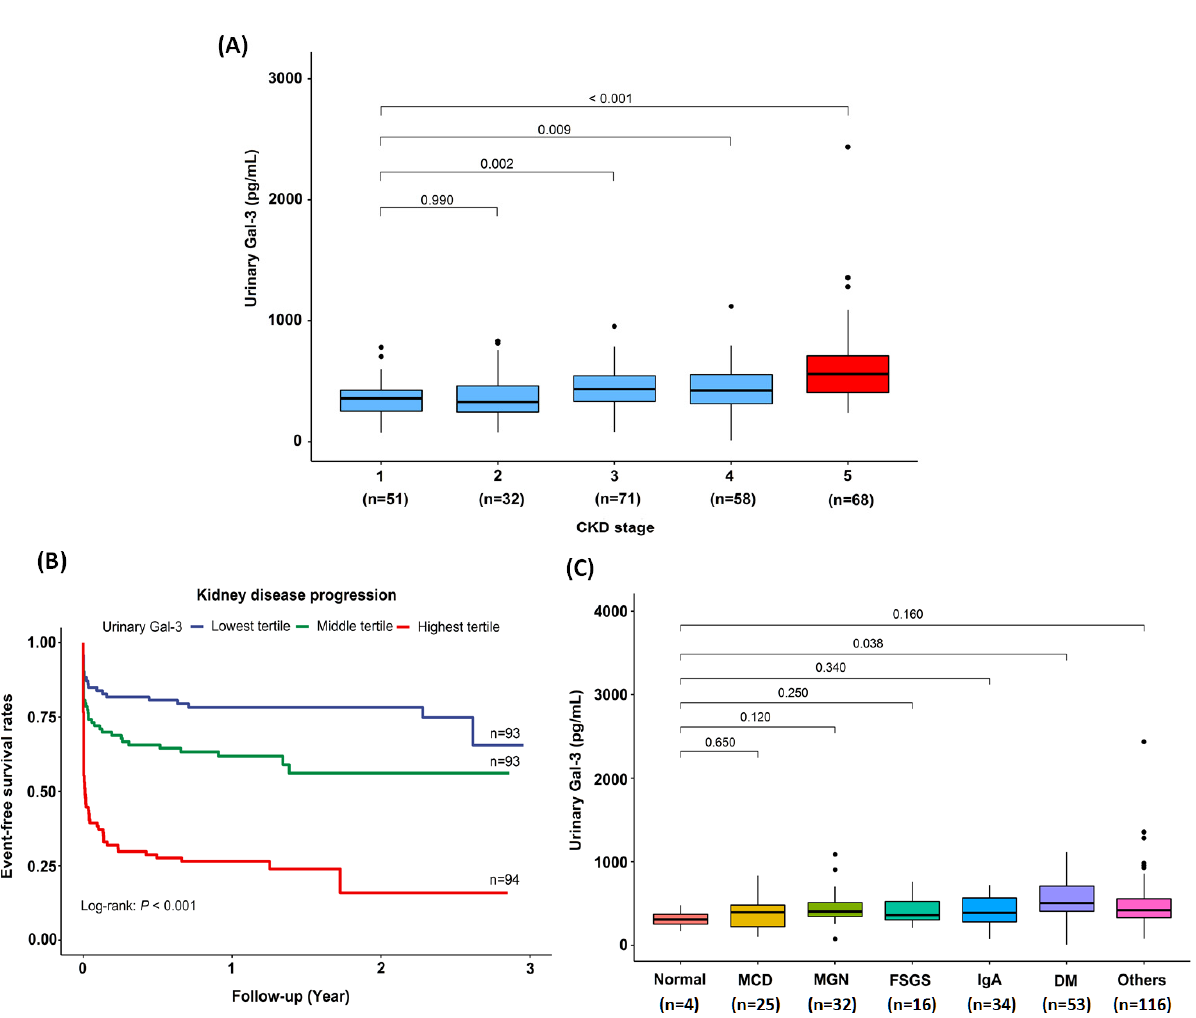
Figure 2. The associations between urinary Gal-3 levels and renal outcomes. ( A ) Urinary Gal-3 levels increased as CKD stage progressed. ( B ) Kaplan–Meier curves for the risks of kidney disease progression in tertiles of urinary Gal-3. ( C ) The associations between different pathological diagnoses and urinary Gal-3 levels. Abbreviations : Gal-3, Galectin-3; CKD, chronic kidney disease; MCD, minimal change disease; MGN, membranous glomerulonephritis; FSGS, focal segmental glomerulosclerosis; IgA, immunoglobulin A; DM, diabetes mellitus.